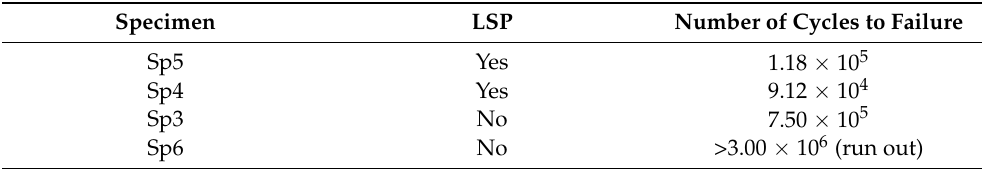
Table 2. Number of cycles to failure for the tested